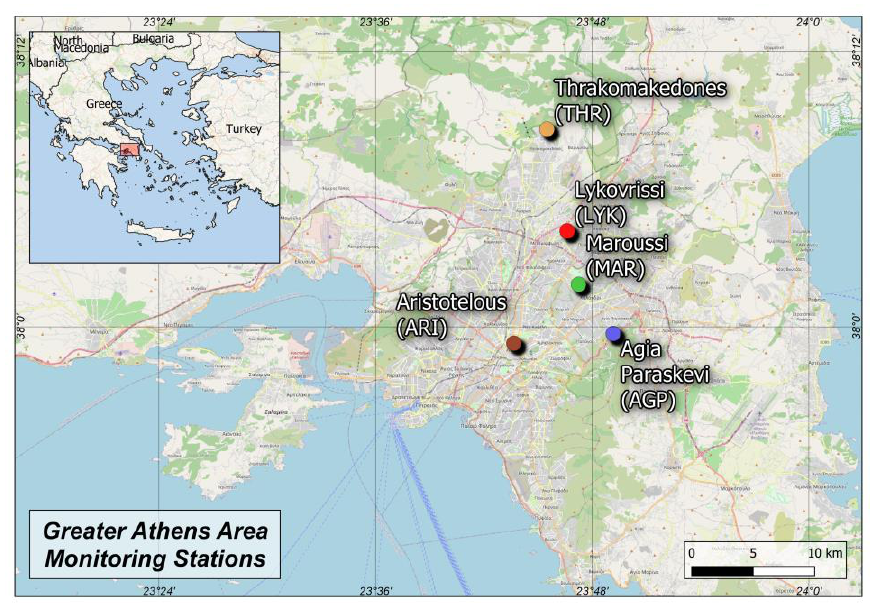
Figure 1. Map with the location of PM 10 monitoring stations within the GAA (Satellite image by ESRI).